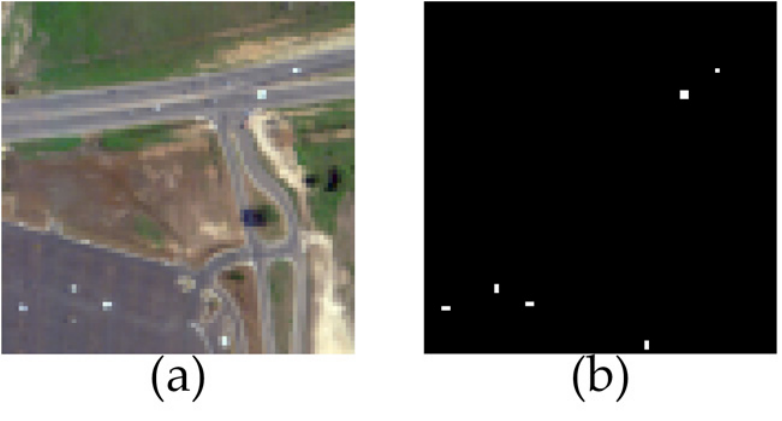
Figure 4. Urban dataset: ( a ) false–color map of the urban dataset; ( b ) ground truth map. MUUFL Gulfport: The third dataset was collected from the University of Southern Mississippi Gulf Park Campus in Long Beach, Mississippi, USA, by the hyperspectral